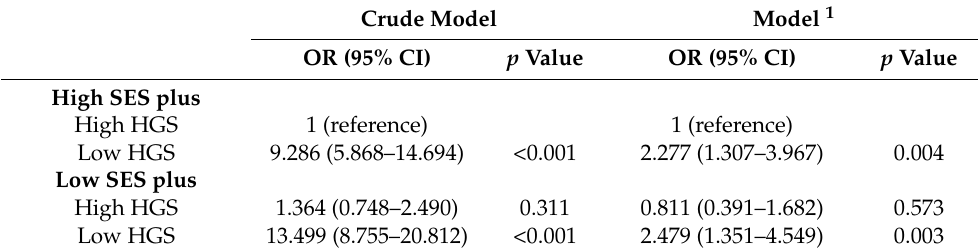
Table 5. Joint association of socioeconomic status and relative handgrip strength with the risk of